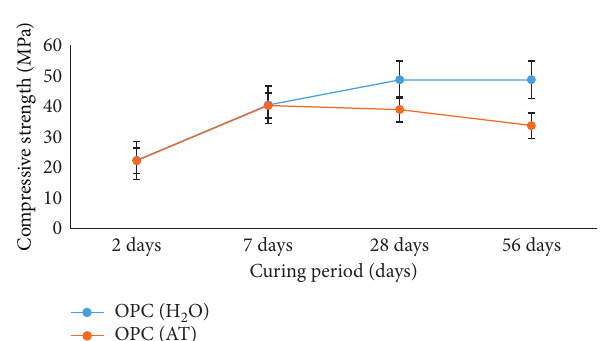
Figure 5: Compressive strength results for control and microbially treated